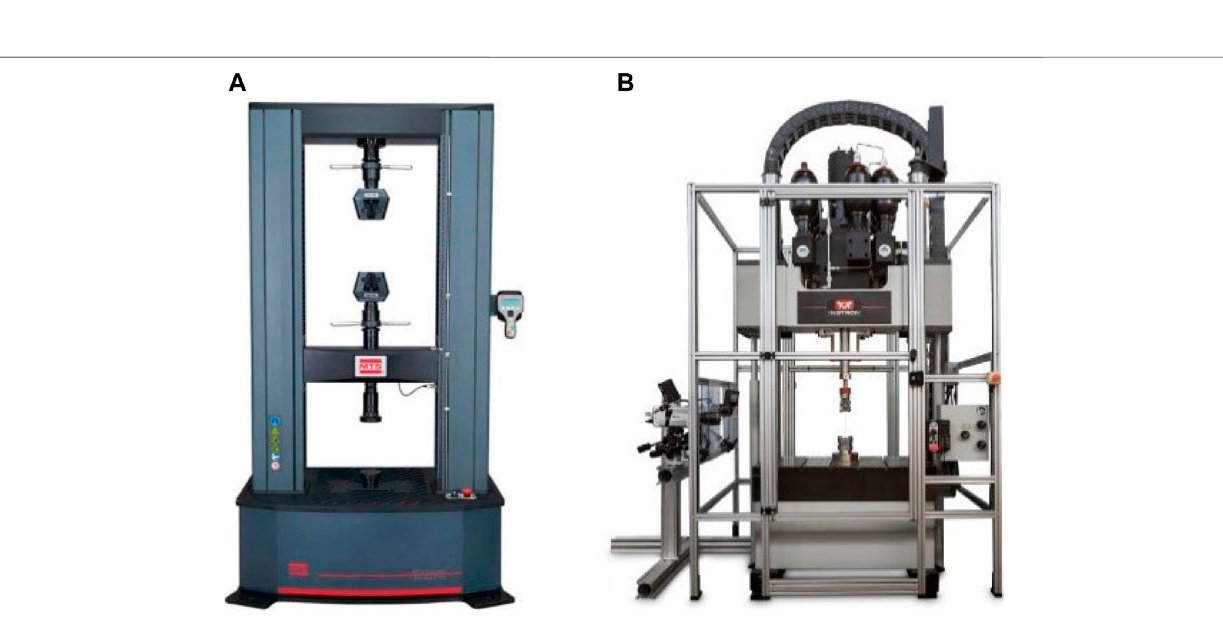
Frontiers in Materials |